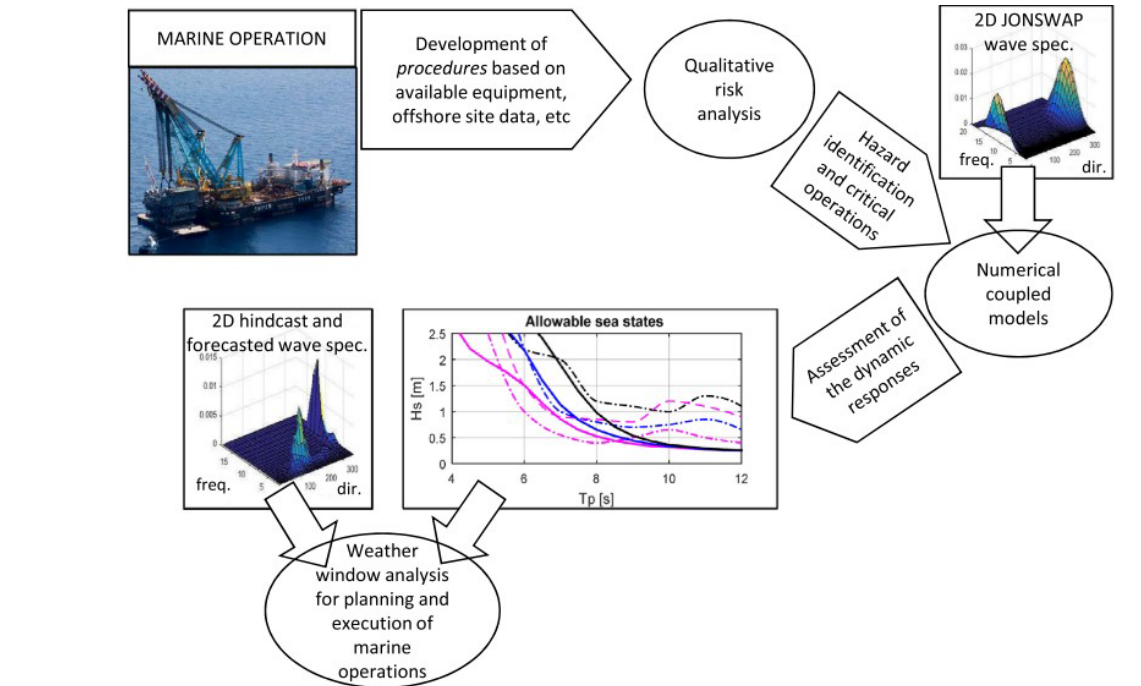
Figure 6. General procedure of assessing operational limits for an offshore marine operation (Acero et al.,